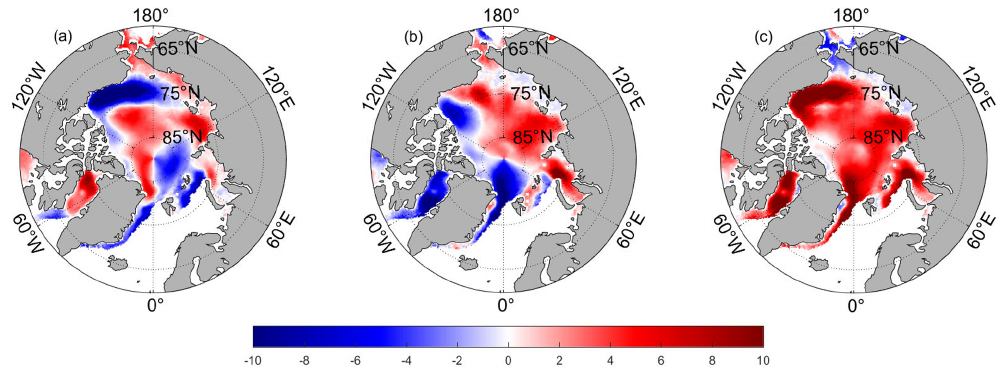
Figure 4. Annual spatial distribution of monotonic variation trends in sea ice motion from 1979 to 2018. (a) The zonal component of drift speed (red shading values indicate enhanced eastward drift, while blue shading values indicate enhanced westward drift, where east is counterclockwise), (b) the meridional component of drift speed (red shading values indicate enhanced northward drift, while blue shading values indicate enhanced southward drift, where north is toward the center of the grid), and (c) total drift velocity (red shading values indicate drift velocity increases, while blue shading values indicate drift velocity decreases). The significance test was carried out by the Mann–Kendall nonparametric test ( p < 0 . 05).